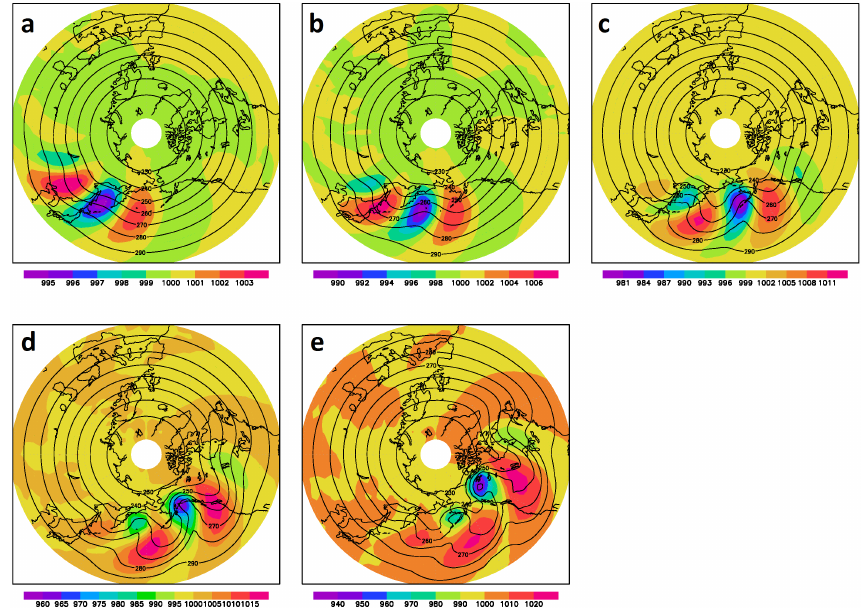
Figure 1. Evolution of the baroclinic wave from time integration with different days. The shadings and contours represent surface pressure (hPa) and temperature (K), respectively: (a) day 6, (b) 7, (c) 8, (d) 9, and (e)